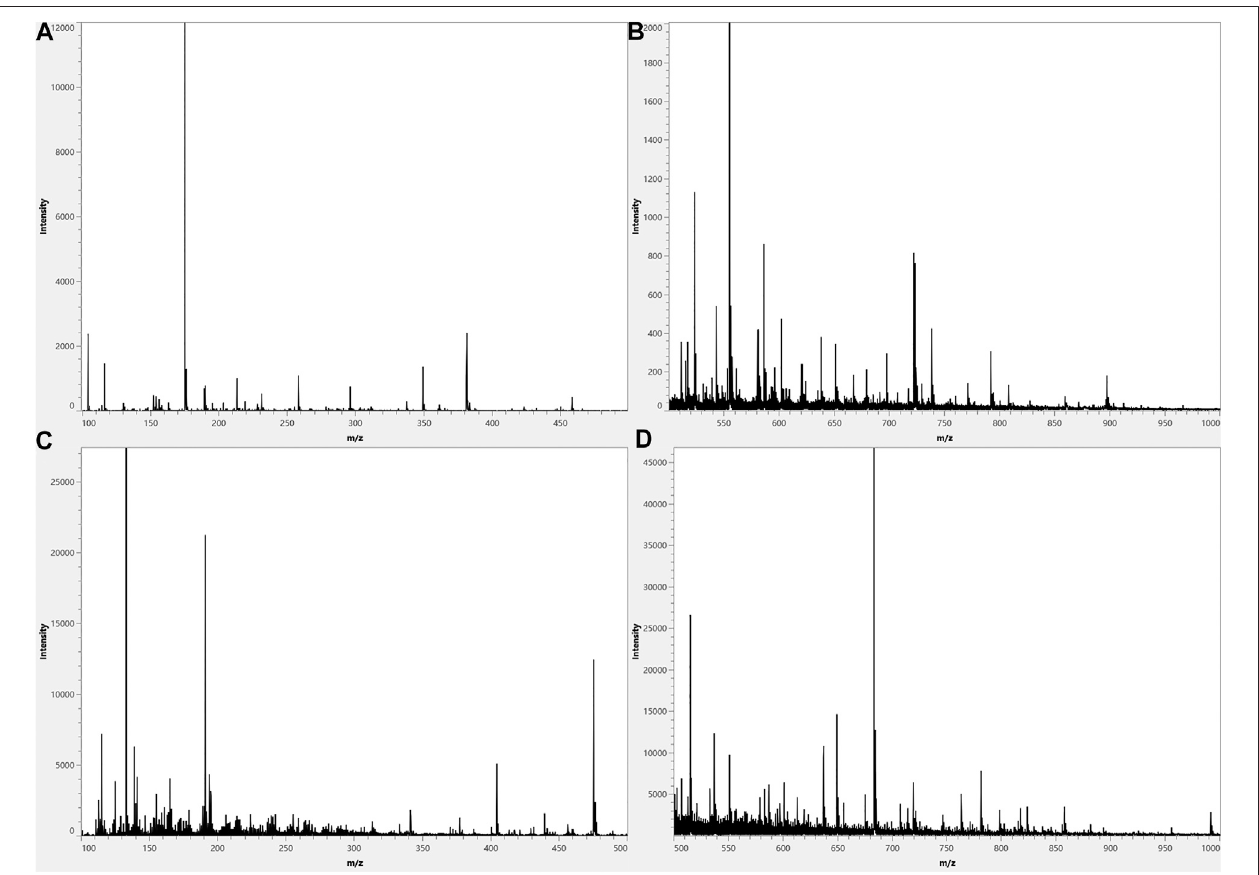
FIGURE 2 | Typical overall average mass spectra acquired from a cross section of the dried root of Isatis indigotica by matrix-assisted laser desorption and ion trap – time-of- fl ight(MALDI-IT-TOF)massspectrometryimaging(MSI)inthespectralrangesof m / z 100 – 500inapositivemode (A) , m / z 500 – 1,000inapositivemode (B) , m / z 100 – 500 in a negative mode (C) , and m / z 500 – 1,000 in a negative mode (D)